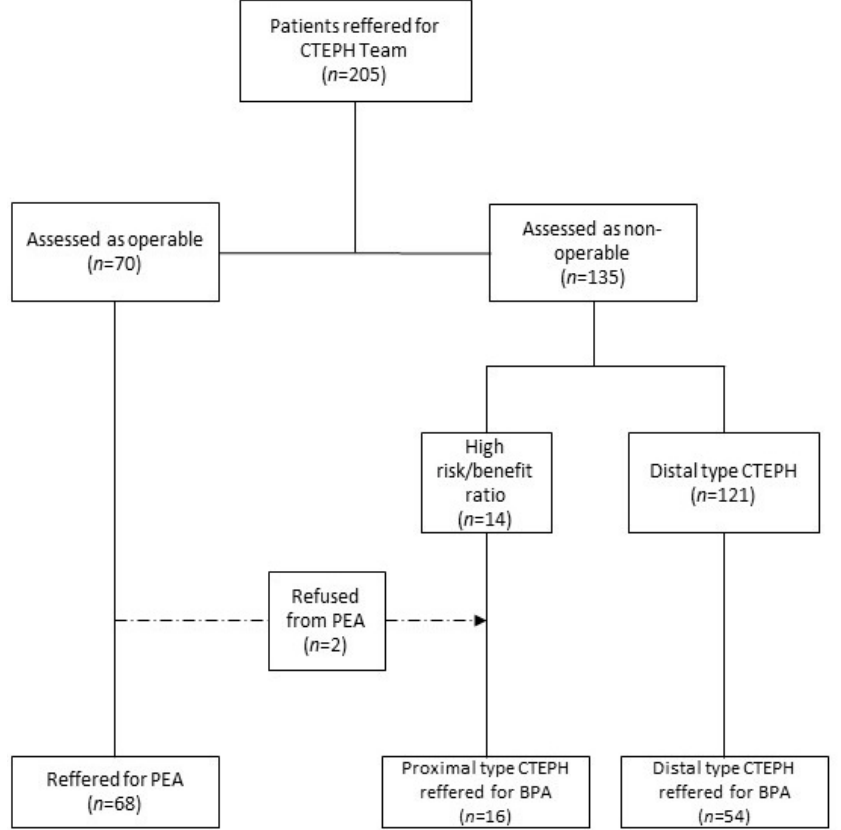
Figure 2. Flow chart presenting distribution of patients with CTEPH qualified to proper